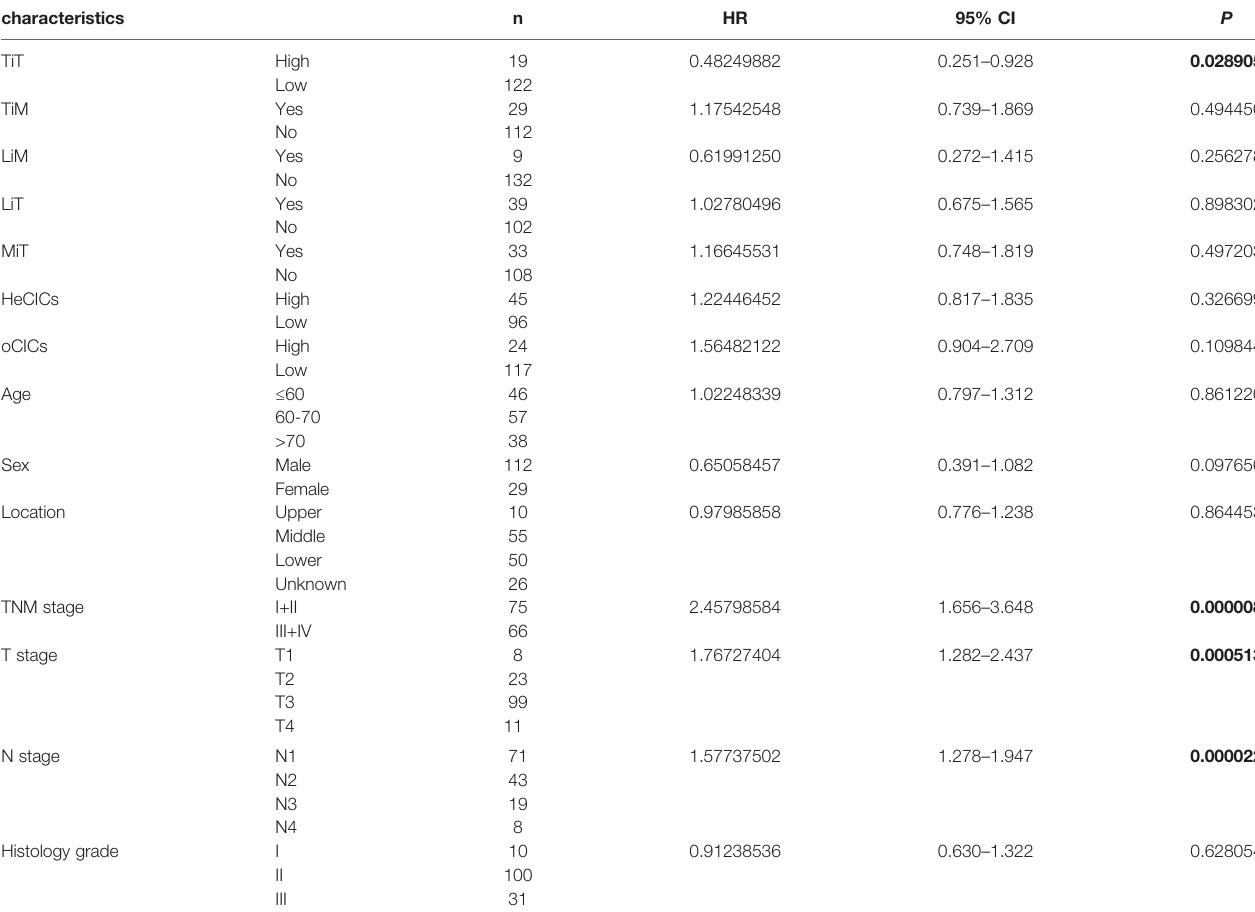
TABLE 3 | Association of overall survival with clinicopathological parameters and CICs by univariate Cox regression analysis.